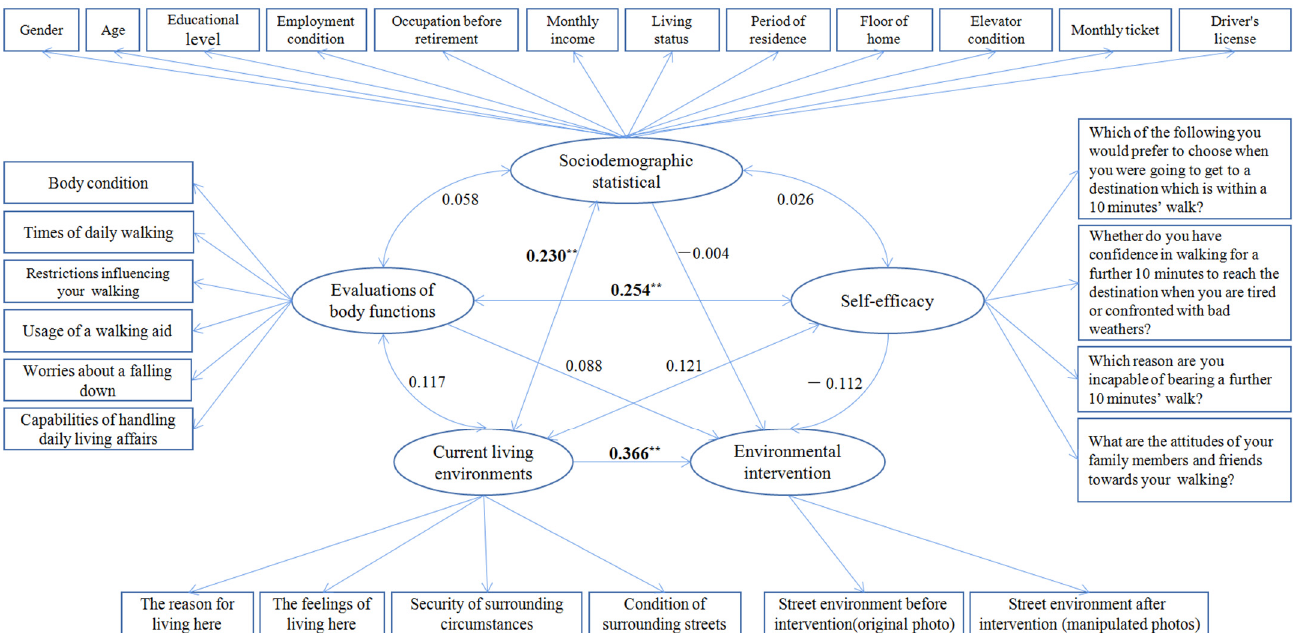
Figure 3. Structural equation modeling (SEM) was established to analyze the data to determine the relationship between sociodemographic characteristics, body functions, self-efficacy, current living environment and street environmental interventions. The numbers in the figure are standardized path coefficients, and ** indicates significance (** p < 0.01).